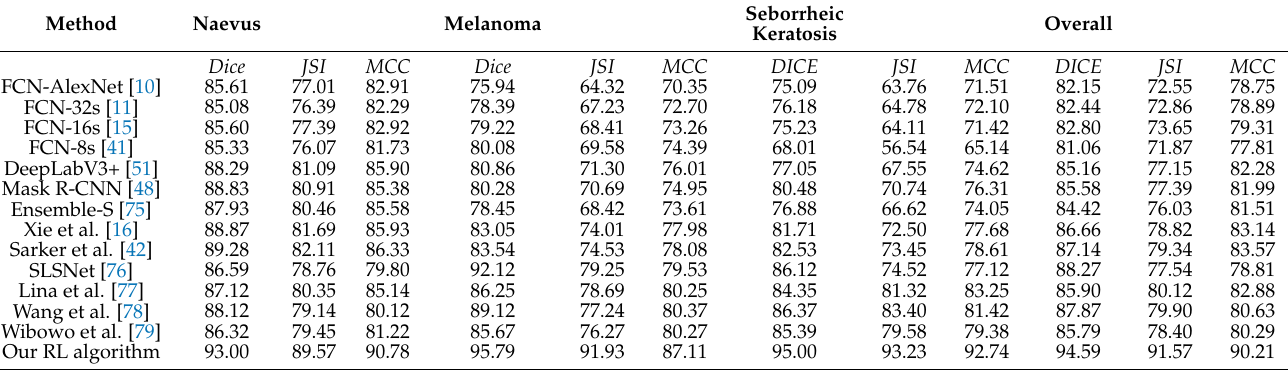
Table 4. For the ISIC 2017 test set, the segmentation results of our proposed RL algorithm and the current state-of-the-art segmentation methods. The statistical measures used are dice score, Jaccard similarity index (JSI), Mathews correlation coefficient (MCC), and the melanoma category seborrheic keratosis (SK). Method